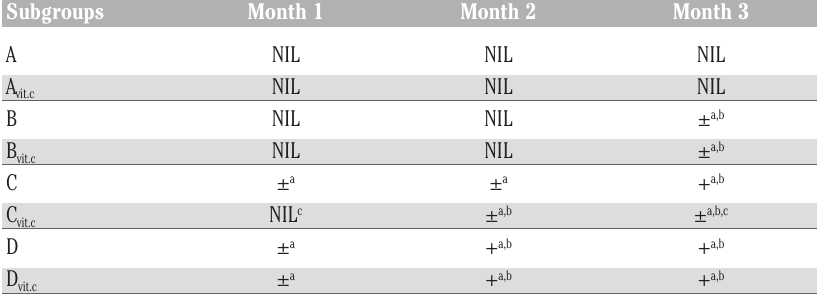
Table 4. Mean urine protein qualitative detection in treated rats.